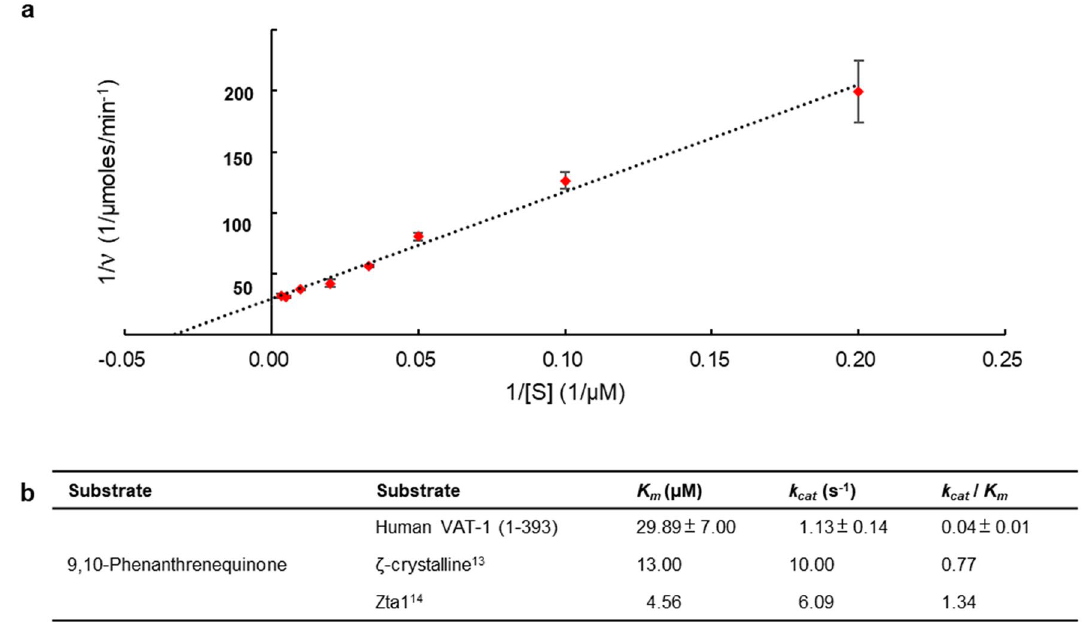
Figure 7. Enzyme kinetics of VAT-1. ( a ) The Lineweaver–Burk reciprocal plot of VAT-1 (full-length) versus PQ. The K m of VAT-1 (full-length) towards PQ was calculated as 30 μM. The initial velocities were measured at 5, 10, 20, 30, 50, 100, 200, and 300 μM. All reactions were measured in triplicates. ( b ) The K m and k cat of VAT-1 (full- length) in compared to that of the ζ-crystalline.